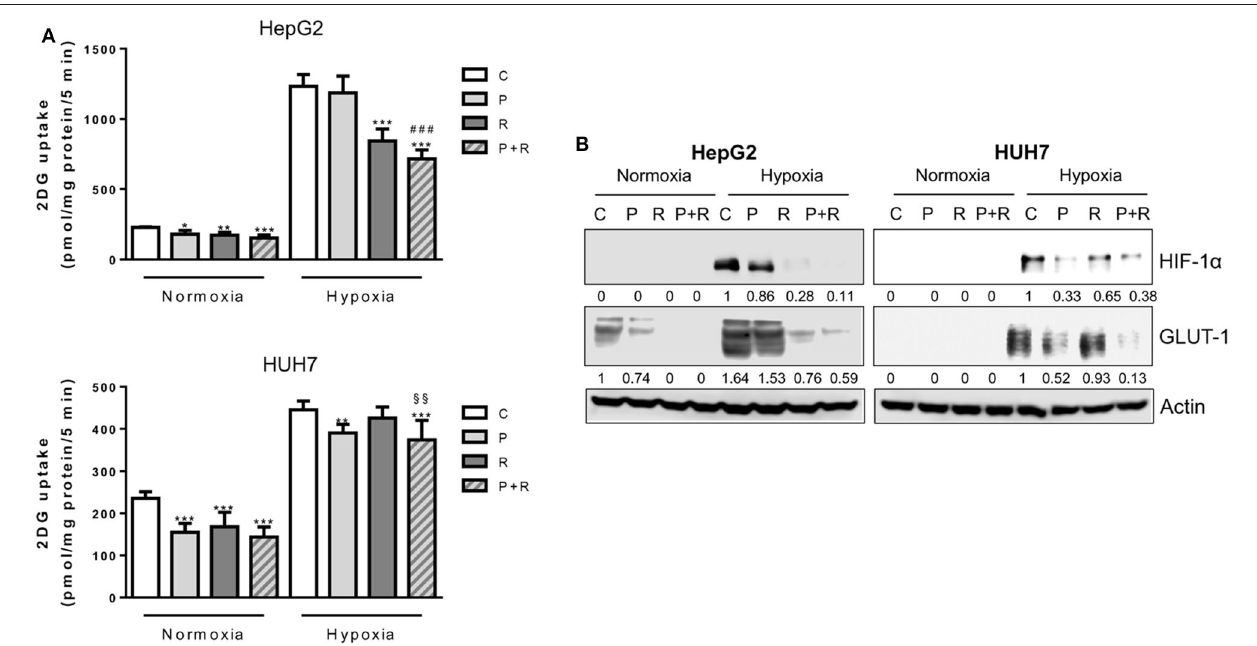
FIGURE 6 | Effects of palbociclib and regorafenib combination on energy metabolism. (A) HepG2 and HUH7 cells were treated with 1 µ M P or 1 and 1.5 µ M R, respectively, alone or in combination, under normoxic and hypoxic conditions for 24h. Glucose uptake was then measured. Data were calculated and expressed as pmol of 2DG/mg protein/5min and are mean values ± SD of three independent experiments. * p < 0.05, ** p < 0.01, *** p < 0.001 vs. C; ### p < 0.001 vs. P; §§ p < 0.01 vs. R. (B) HepG2 and HUH7 cells, treated as in panel (A) , were lysed and the expression of the indicated proteins was evaluated by Western blot analysis. Results are representative of two independent